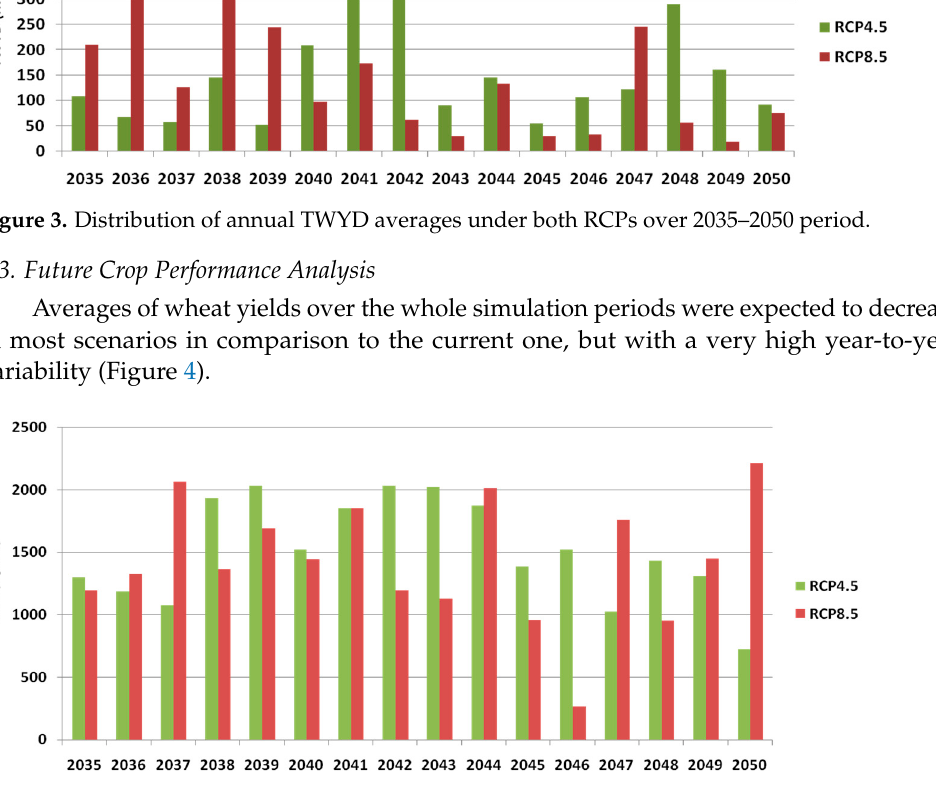
Figure 4. Annual yields averages of wheat crops (under both RCPs) over 2035–2050.